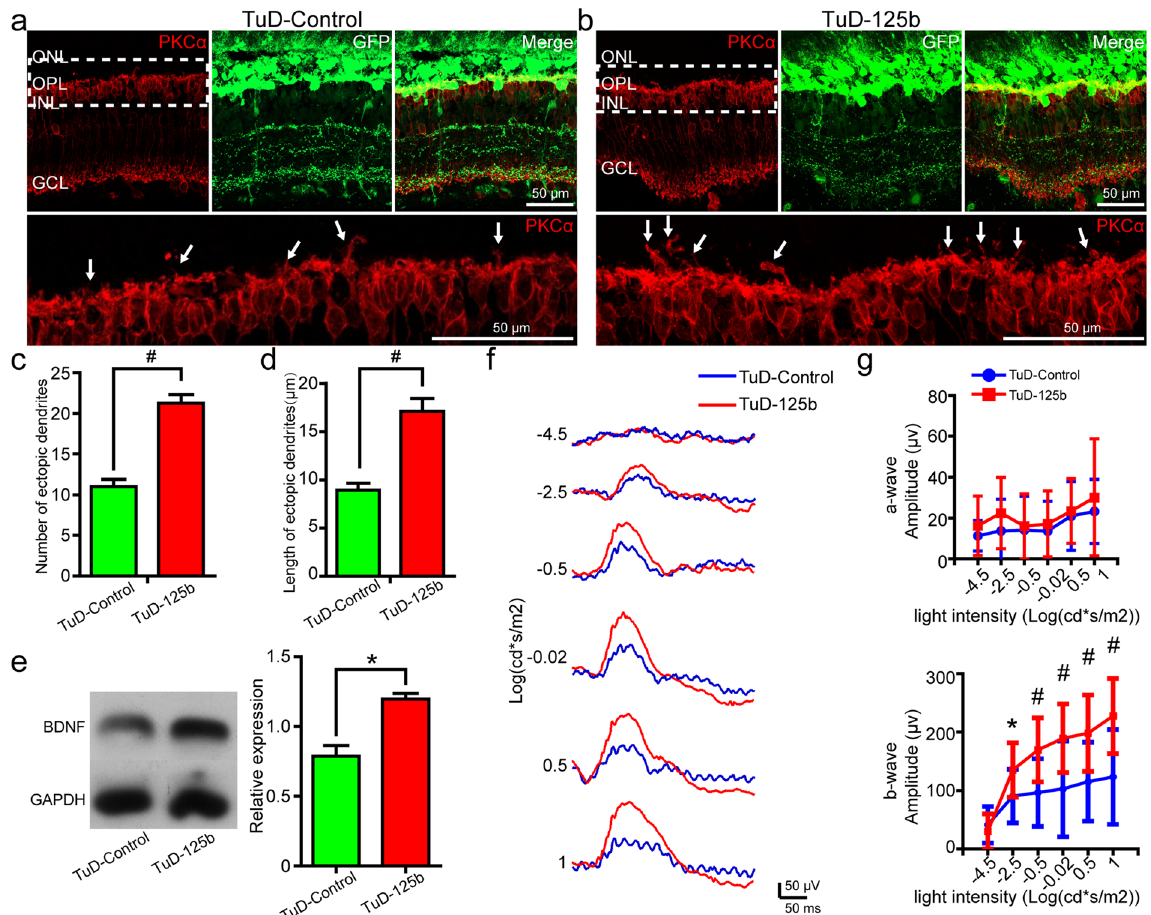
Figure 5. Downregulation of miR-125b-5p increased the number and length of RBC ectopic dendrites and the ERG responses in RCS rats. Immunostaining of PKC α in the retinae of P60 RCS rats, five weeks after subretinal injection of ( a ) TuD-Control or ( b ) TuD-125b virus. Bottom sub-panel shows magnification of the dotted area in the top left subpanel. Arrows indicate ectopic dendrites. ( c ) Number of RBC ectopic dendrites in RCS rats, five weeks after TuD-control or TuD-125b treatment per field view (213 µ m × 213 µ m) (bars show means; error- bars, SEM; n = 5). ( d ) Same for length of ectopic dendrites (n = 5). ( e ) Western blot analysis of BDNF expression in retinae of RCS rats after TuD-control or TuD-125b treatment, five weeks post-surgery (bars, means; error- bars, SD, n = 4). GAPDH was used as a loading control. For original blot images, please see Supplementary Fig. 13. ( f ) Representative ERG traces in RCS rats, five weeks after subretinal injection of TuD-control or TuD-125b. ( g ) Group data for the amplitude of a-waves (top) and b-waves (bottom) from ERG recordings in RCS rats, five weeks after surgery (bars, means; error-bars, SD, n = 13). ONL: outer nuclear layer; OPL: outer plexiform layer; INL: inner nuclear layer; GCL: ganglion cell layer. * p < 0.05, # p <